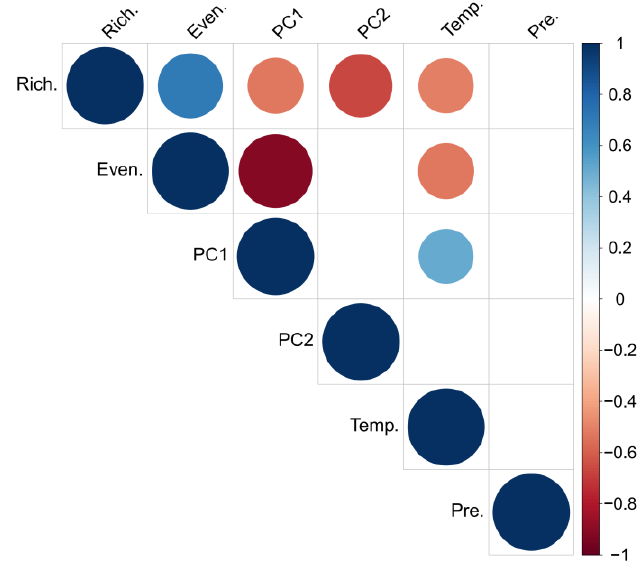
Figure 8. A correlogram of the diatom-inferred proxies including richness (rich.), evenness (even.), PCA axis 1 (PC1), and PCA axis 2 (PC2) with the meteorological data such as temperature (temp.) and precipitation (pre.) during 1960 – 2013 in LSP. In the plot, the color bar on the right side shows the correlation values.